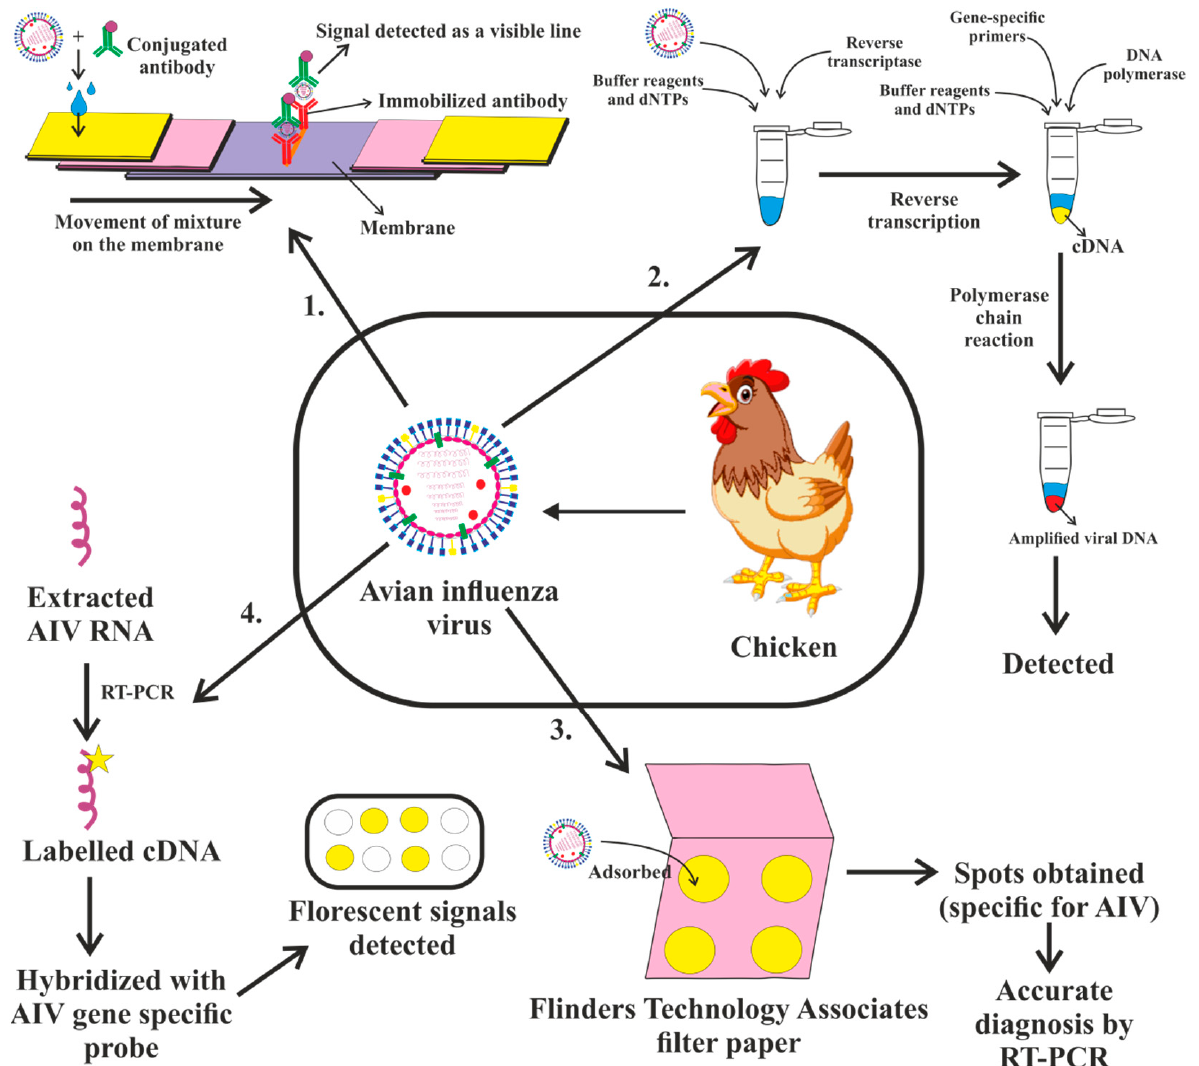
Figure 7. Different strategies for the detection of avian influenza virus. (1) Depicts immunochromatographic detection of AIV, (2) represents detection of AIV through RT-PCR technique, (3) depicts detection of AIV using Flinders Technology Associates filter paper technique and 4) depicts detection of AIV using DNA microarray technology (AIV = Avian influenza virus).